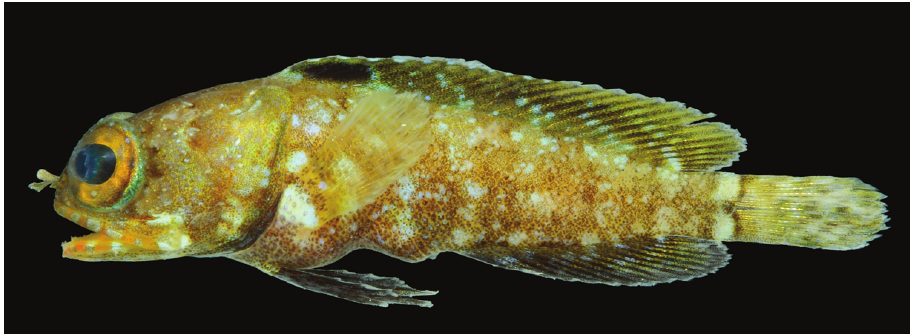
Figure 1. Opistognathus thionyi , CIUFES 2054, 27.5 mm SL, Dogaressa Seamount, Vitória-Trindade Chain. Photograph by Raphael M. Macieira.